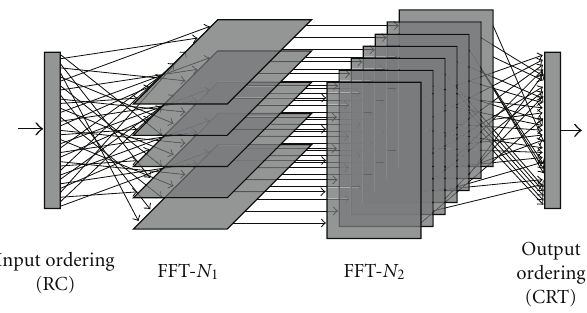
Figure 1: Steps in a PFA decomposed